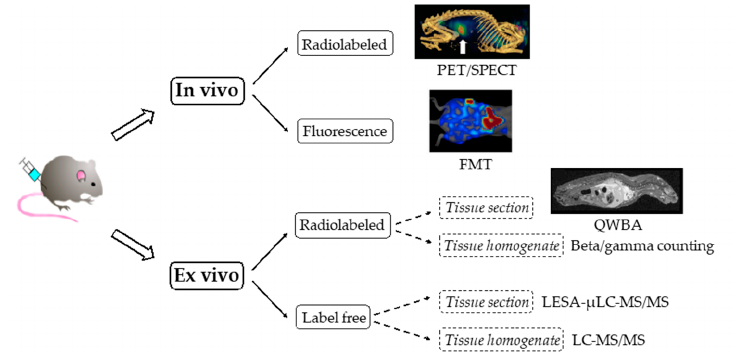
Figure 3. Overview of the different in vivo and ex vivo methods used to study the biodistribution of ADCs in preclinical model. PET: positron emission tomography. SPECT: single-photon emission computed tomography. FMT: fluorescence molecular tomography. QWBA: quantitative whole-body autoradiography. LC–MS / MS: liquid chromatography tandem mass spectrometry. LESA– µ LC–MS / MS: liquid extraction surface analysis coupled to liquid chromatography tandem mass spectrometry. PET / SPECT, FMT, and QWBA images were extracted from doi:10.18632 / oncotarget.27263; doi:10.1158 / 1535-7163.MCT-15-1012 and doi:10.1124 / dmd.115.069021,